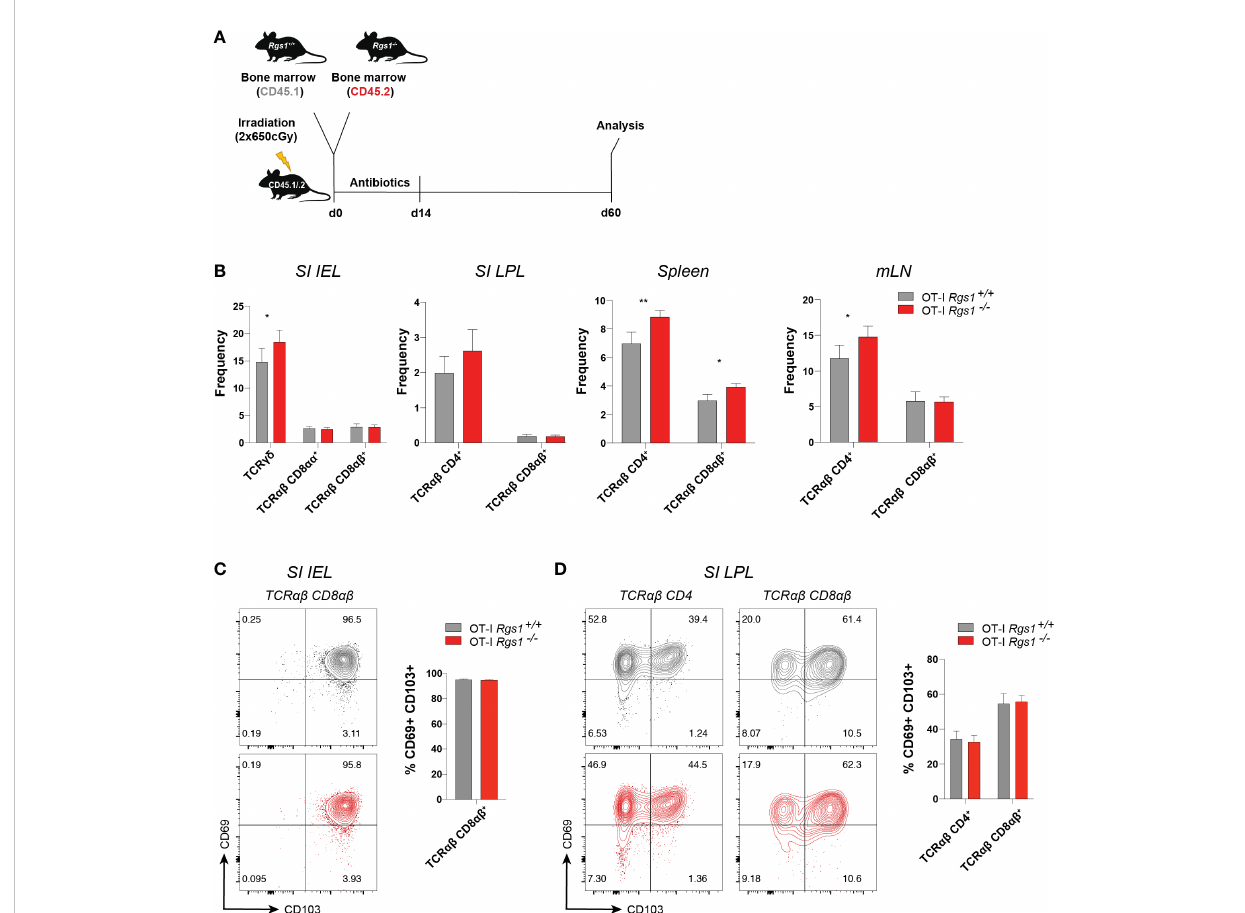
FIGURE 2 Absence of Rgs1 does not affect the frequency of small intestinal resident and circulating T cell subsets under homeostatic conditions. (A) Experimental set-up. Irradiated CD45.1/.2 recipient B6 mice were reconstituted with a 1:1 mixture of congenic Rgs1 +/+ (CD45.1): Rgs1 -/- (CD45.2) bone marrow cells. At day 60 post-reconstitution T cell subsets from different organs were isolated for analysis. (B – D) Frequencies of the respective T cell subsets within the isolated viable cell population in the (B) Small intestinal epithelium (SI IEL), lamina propria (SI LPL), spleen, and mesenteric lymph node (mLN) (n=16-21, obtained from 3 independent experiments, mean ± SEM, Wilcoxon test, *, p < 0.05; **, p < 0.01; ***, p < 0.001). (C, D) Cell surface expression of T RM marker CD69 and CD103 on TCR ab T cell subsets isolated from (C) SI epithelium (SI IEL) TCR ab CD4 - CD8 ab + T cells, (TCR ab CD8 ab ) and (D) SI TCR ab CD4 + CD8 ab - T cells (TCR ab CD4), and TCR ab CD4 - CD8 ab + (TCR ab CD8 ab ) LPL) (grey, OT-I Rgs1 +/+ cells; red, OT-I Rgs1 -/- cells; n=11, pooled from 2 independent experiments, mean ± SEM, Wilcoxon test, *, p < 0.05; **, p <